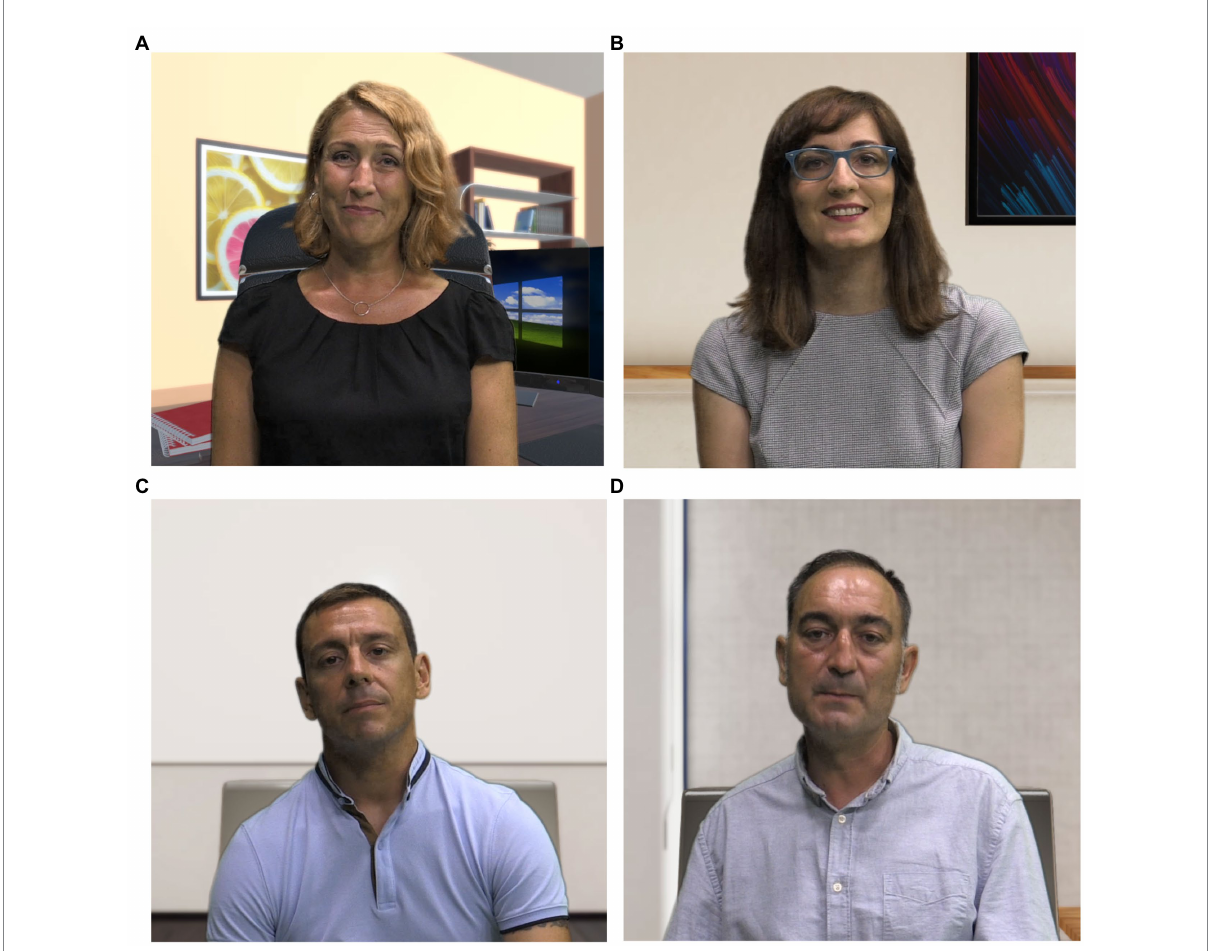
FIGURE 2 Virtual agent characters: (A) organizer agent, (B) communicative agent, (C) passive agent, and (D) logical